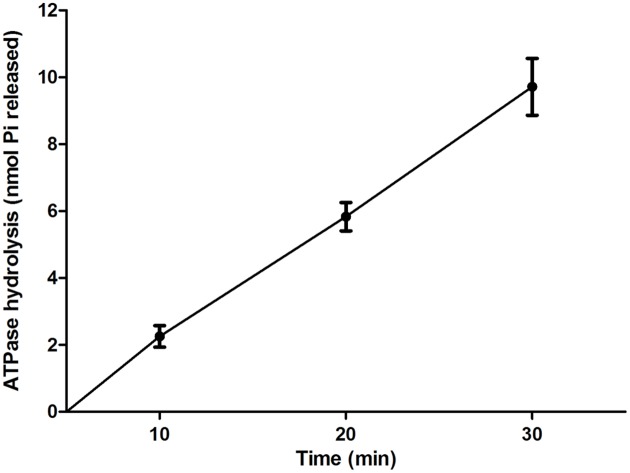
ATPase activity of EivC. The His-EivC fusion protein was purified by nickel-affinity chromatography. ATP hydrolysis by the purified His-EivC fusion protein was determined using a malachite green assay over a period of 30 min. Error bars indicate standard deviations.